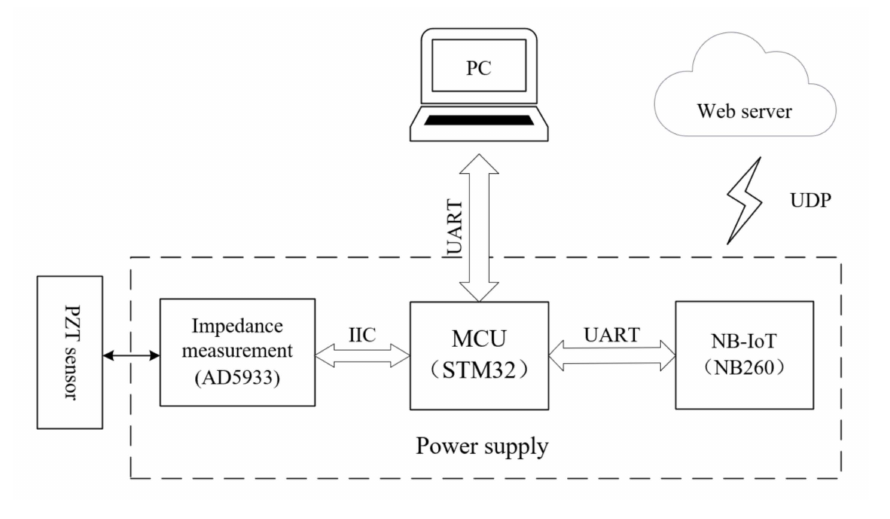
Figure 2. Wireless impedance measurement system model.